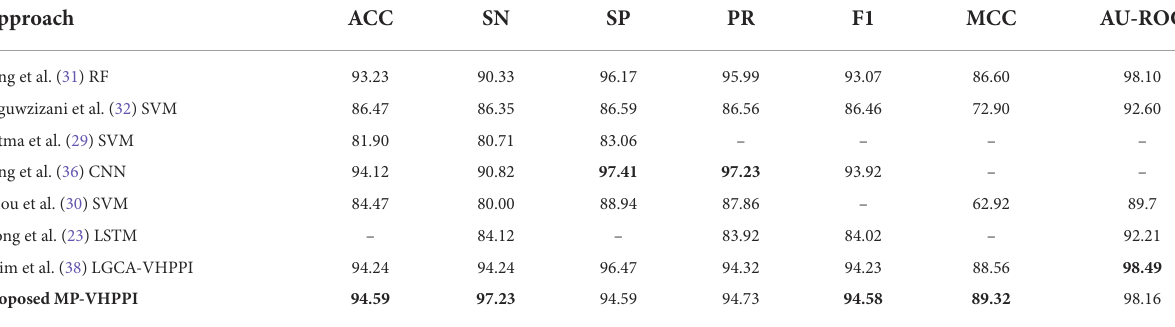
TABLE 4 Performance comparison of proposed MP-VHPPI with existing viral-host PPI predictors over benchmark DeNovo dataset (29) in terms of 7 different evaluation measures.